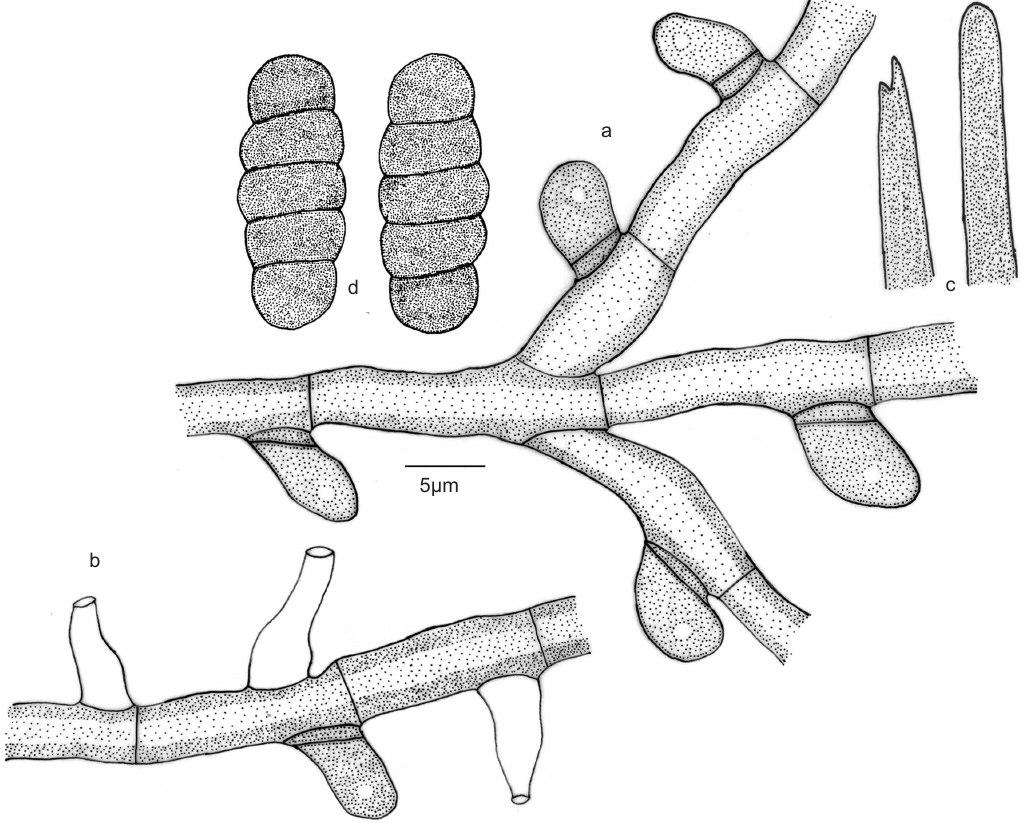
Figure 3. Meliola gouaniae Hansf. var. keralica var. nov. a - Appressorium; b - Phialide; c - Apical portion of the mycelial setae; d -